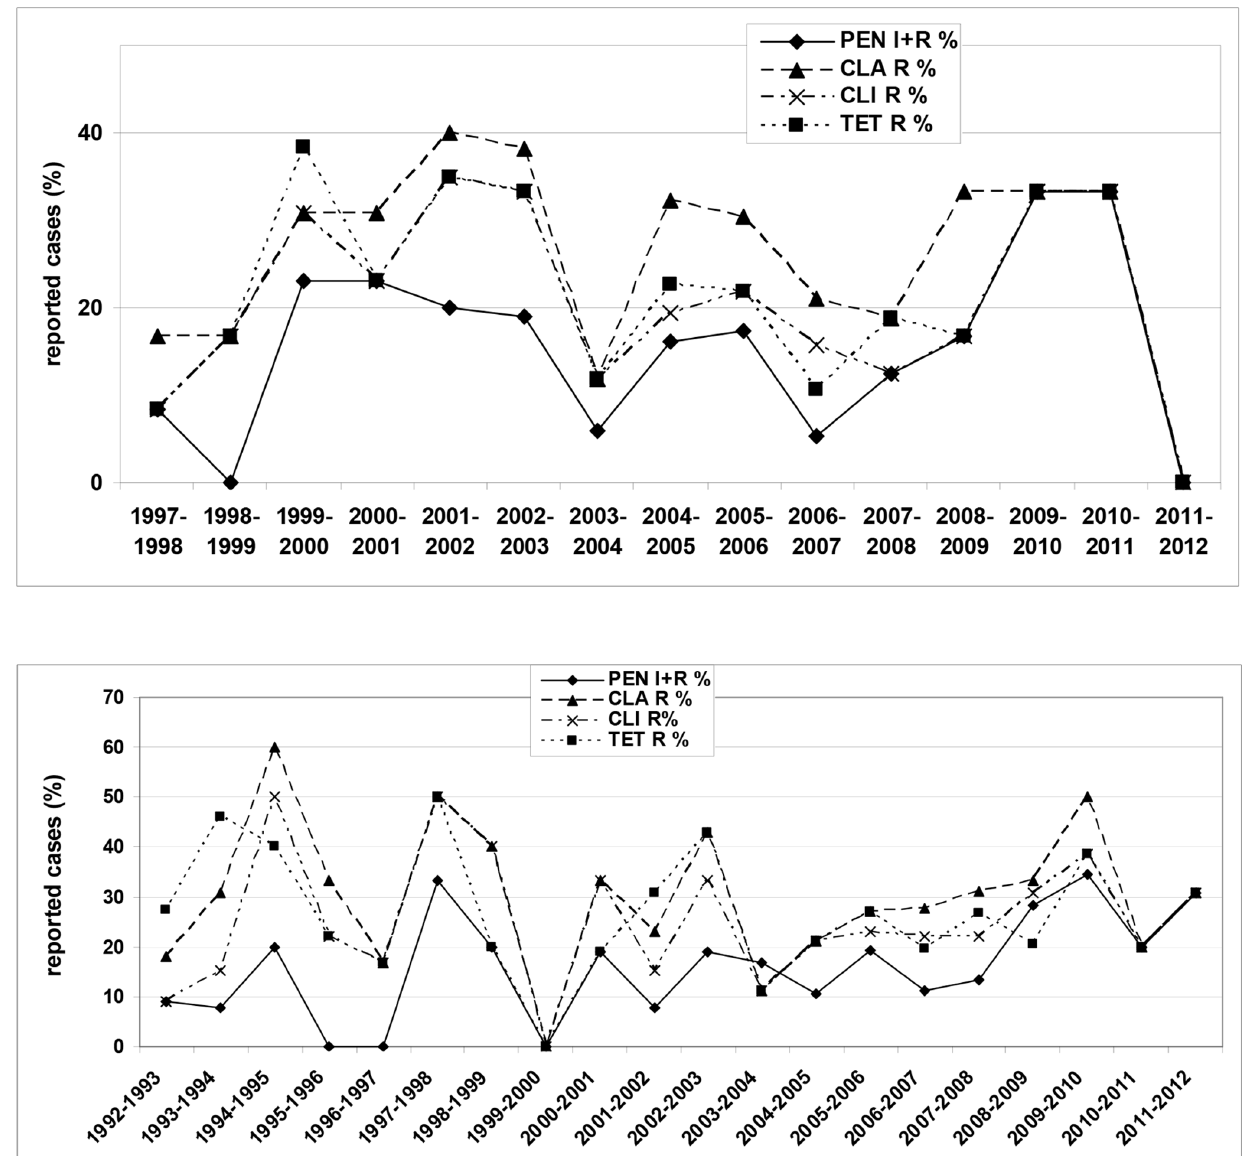
Figure 2. Percentage of resistant serotype 6B isolates from IPD among German children (top) and adults (bottom). PEN: penicillin (breakpoints S, I, R ( m g/ml ): # 0.06, 0.12–1, $ 2), CLA: clarithromycin (breakpoints S, I, R ( m g/ml ): # 0.25, 0.5, $ 1), CLI: clindamycin(breakpoints S, I, R ( m g/ml ): # 0.25, 0.5, $ 1), TET: tetracycline (breakpoints S, I, R ( m g/ml ): # 2, 4, $ 8).